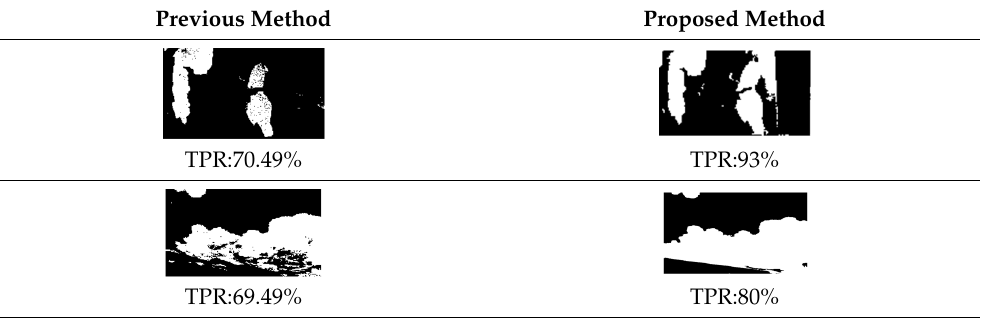
Figure 15. Performance metrics of model .